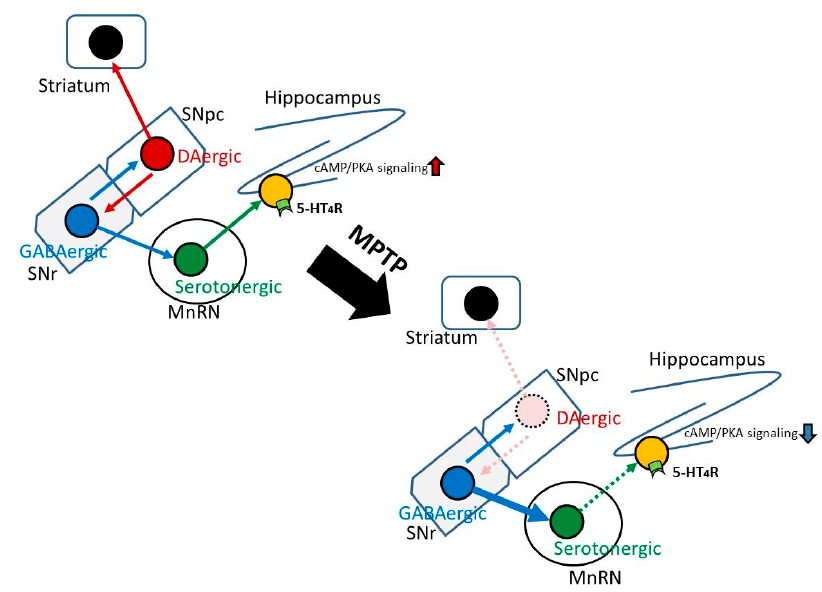
Figure 7. The proposed model for cognitive impairment in PD mice and the predicted neural circuit responsible for it. The degeneration of SNpc dopaminergic (DAergic) neurons might affect γ -aminobutyric acid-ergic (GABAergic) neurons in the SNr close to the SNpc, which in turn, may influence serotonergic neurons in the MnRN receiving GABAergic neurons from the SNr, resulting in hippocampal dysfunction.